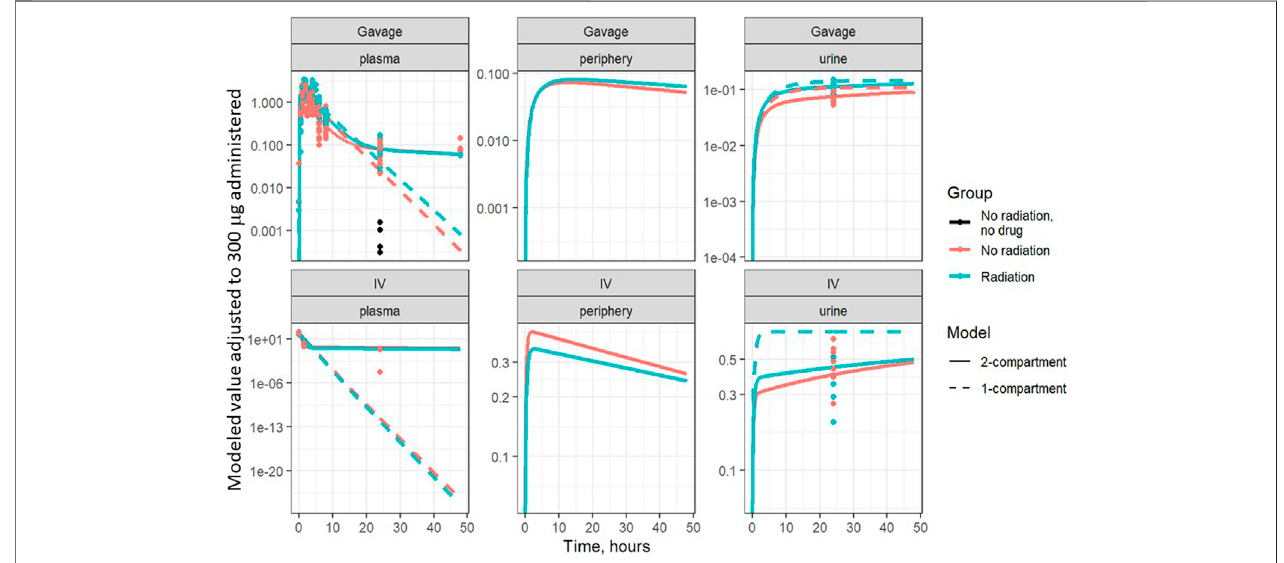
FIGURE 3 | Same data as Figure 2 , plotted on a log scale. Points are measured data values. Solid curves are fi tted values from the two-compartment model, not adjusted for bioavailability. Dashed lines represent the best- fi t one-compartment